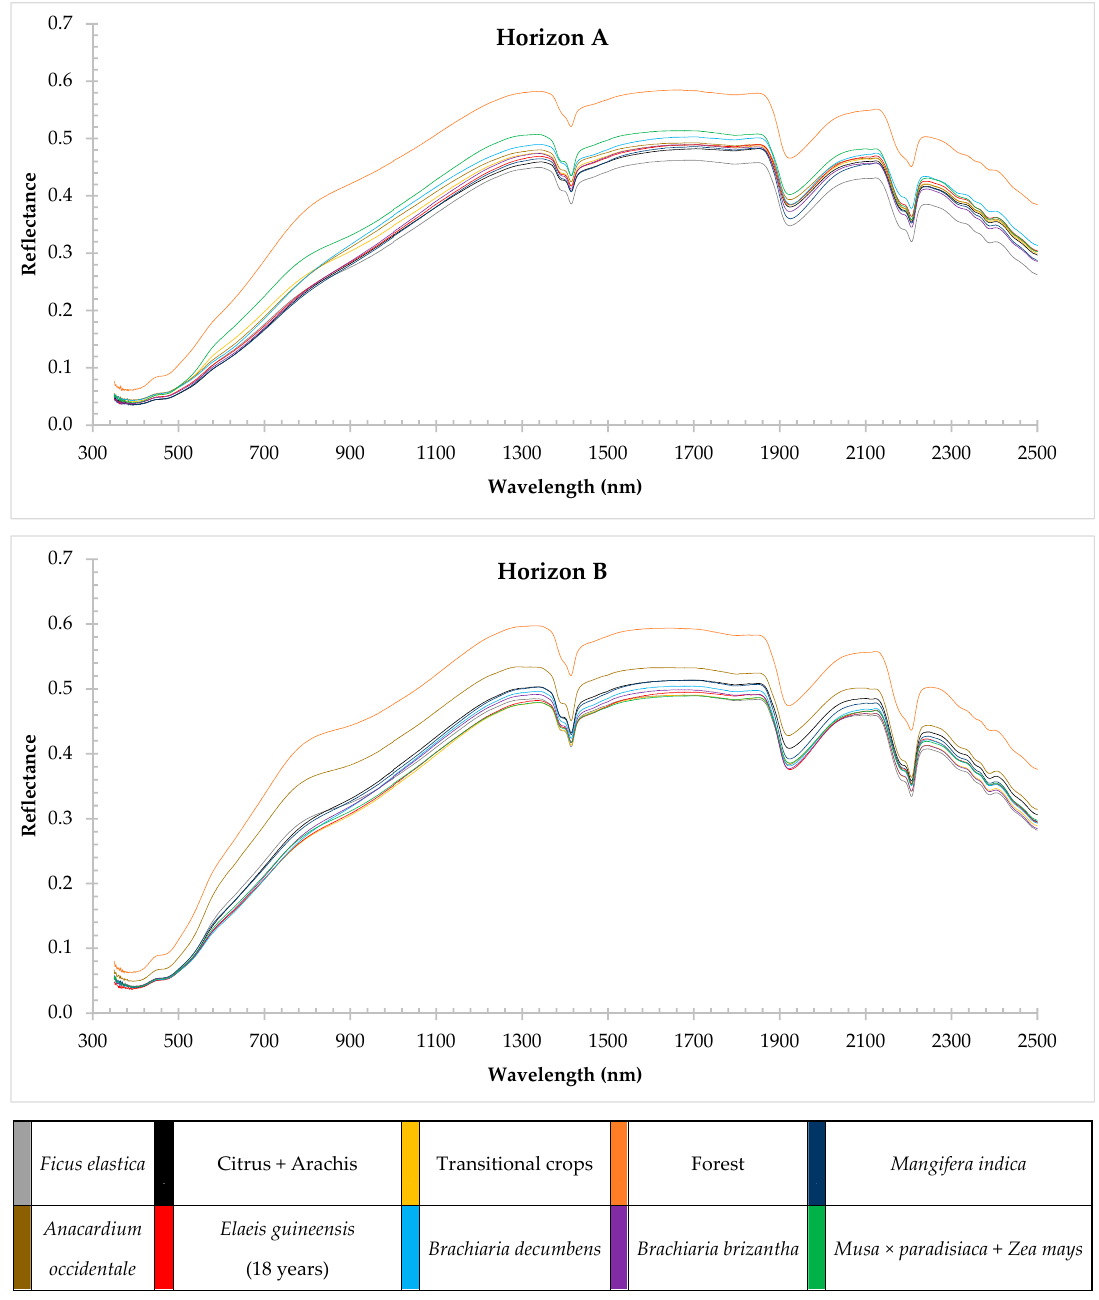
Figure 1. Spectral responses of the soils studied in the VIS-NIR region horizon A and horizon B.